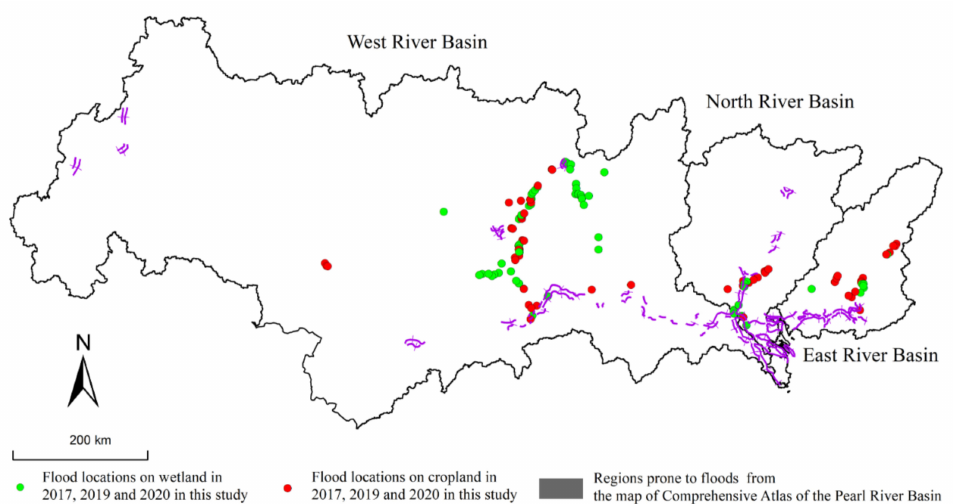
Figure 14. Comparison of the flood locations obtained in this study and the distribution of embankments obtained from the map of Comprehensive Atlas of the Pearl River Basin released by Pearl River Water Resources Commission (PRWRC)